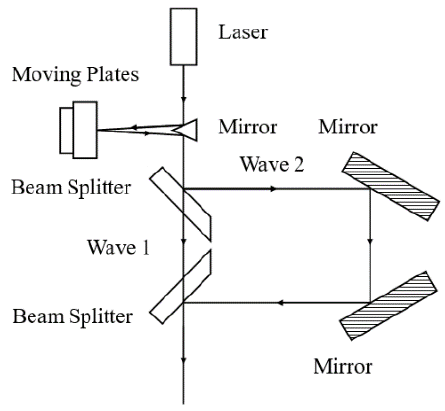
Figure 3. Basic components of a laser Doppler interferometer. The laser beam is directed at the surface of interest, based on which the vibration amplitude and frequency can be extracted due to the motion of the target surface.